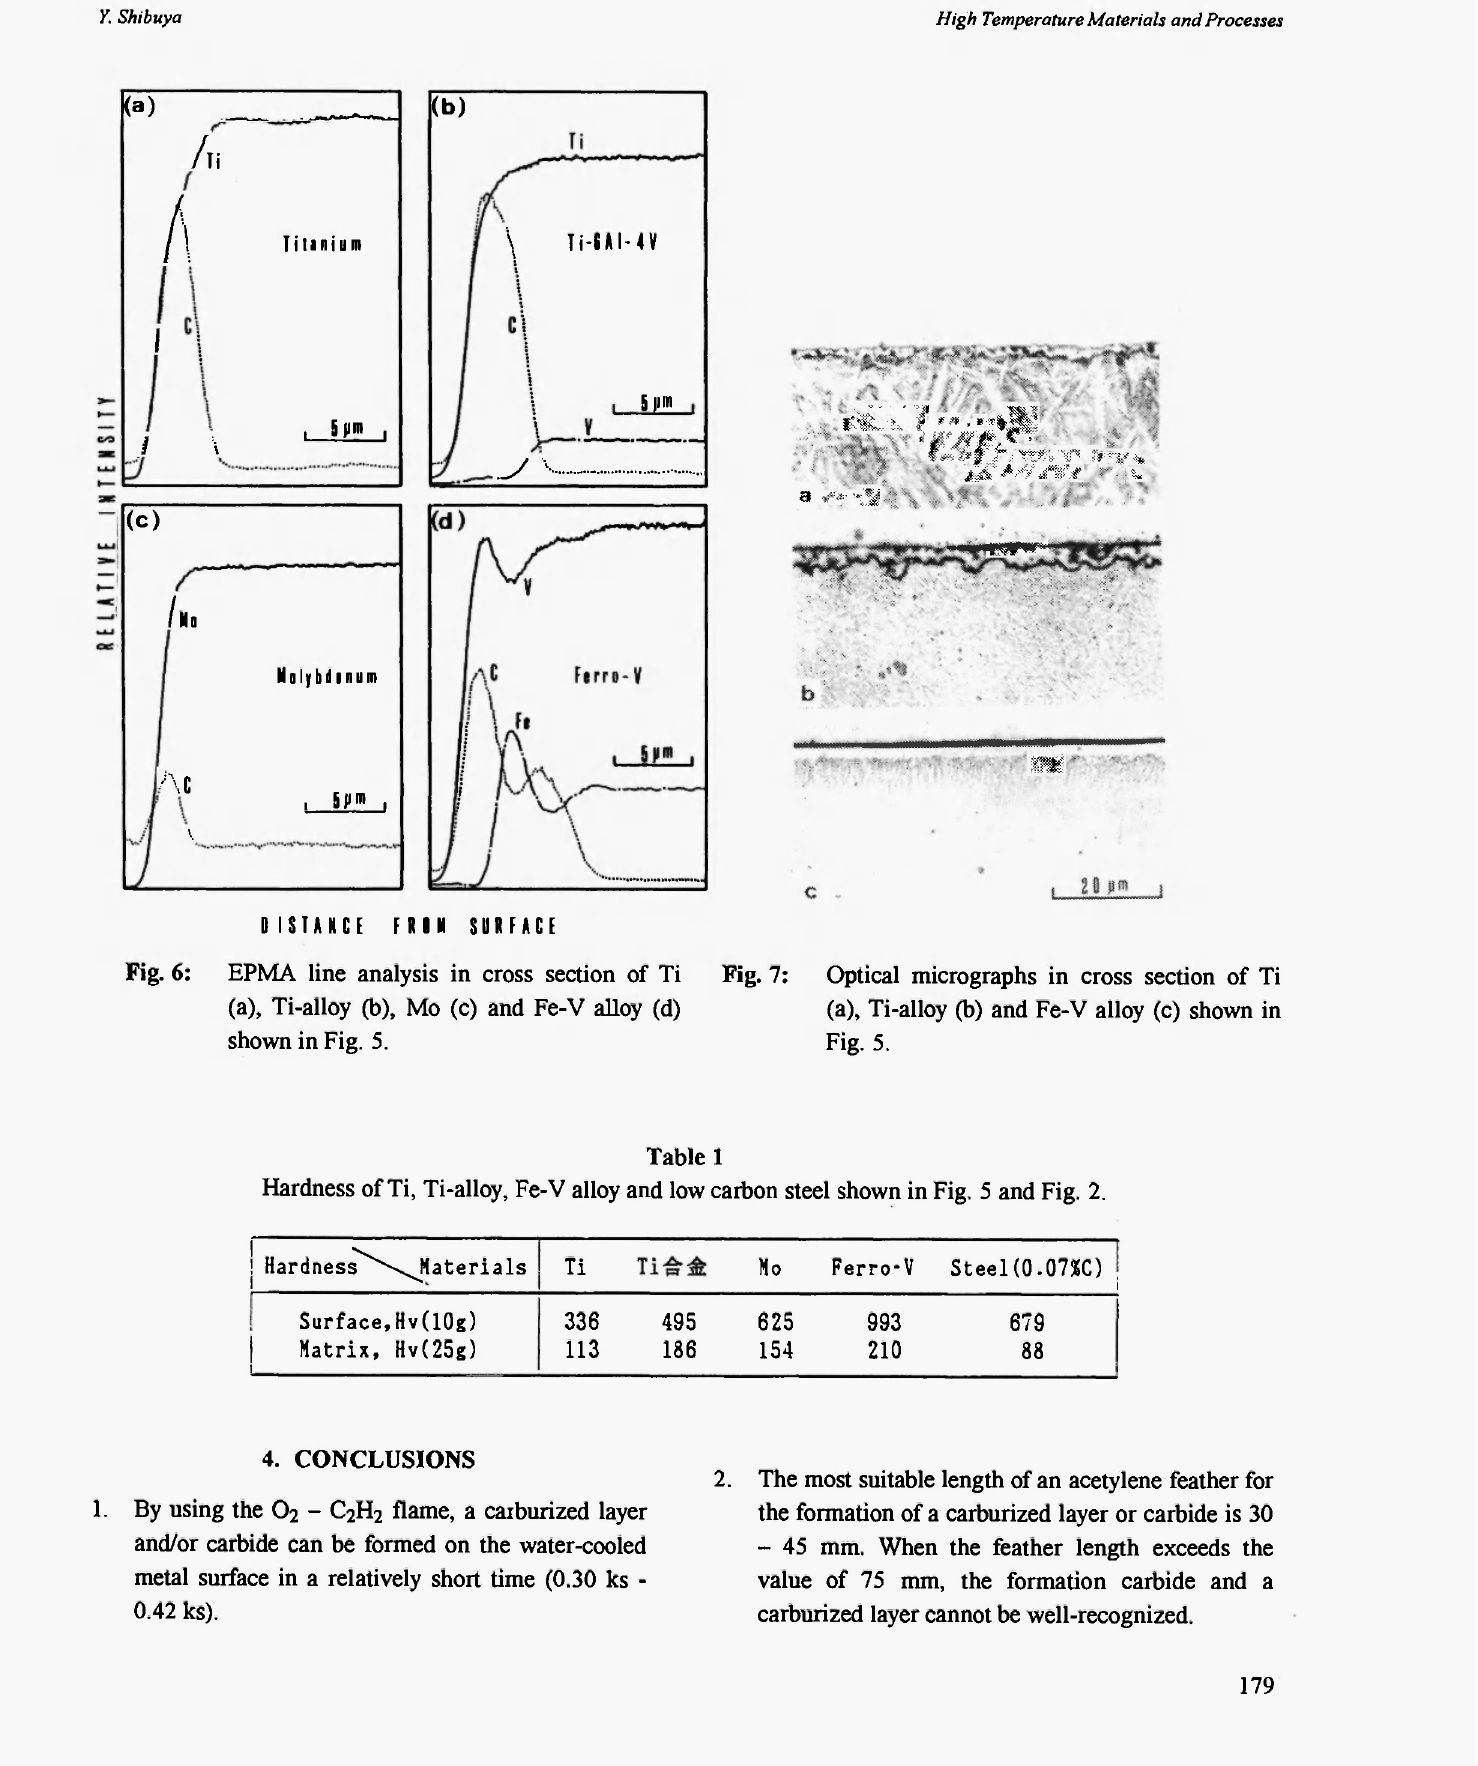
Hardness of Ti, Ti-alloy, Fe-V alloy and low carbon steel shown in Fig. 5 and Fig.